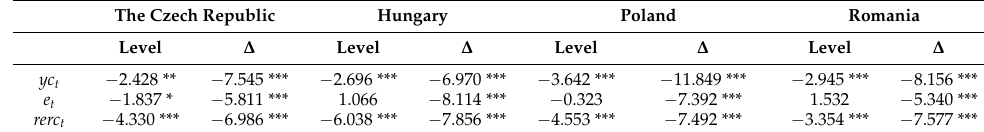
Table 2. Unit root